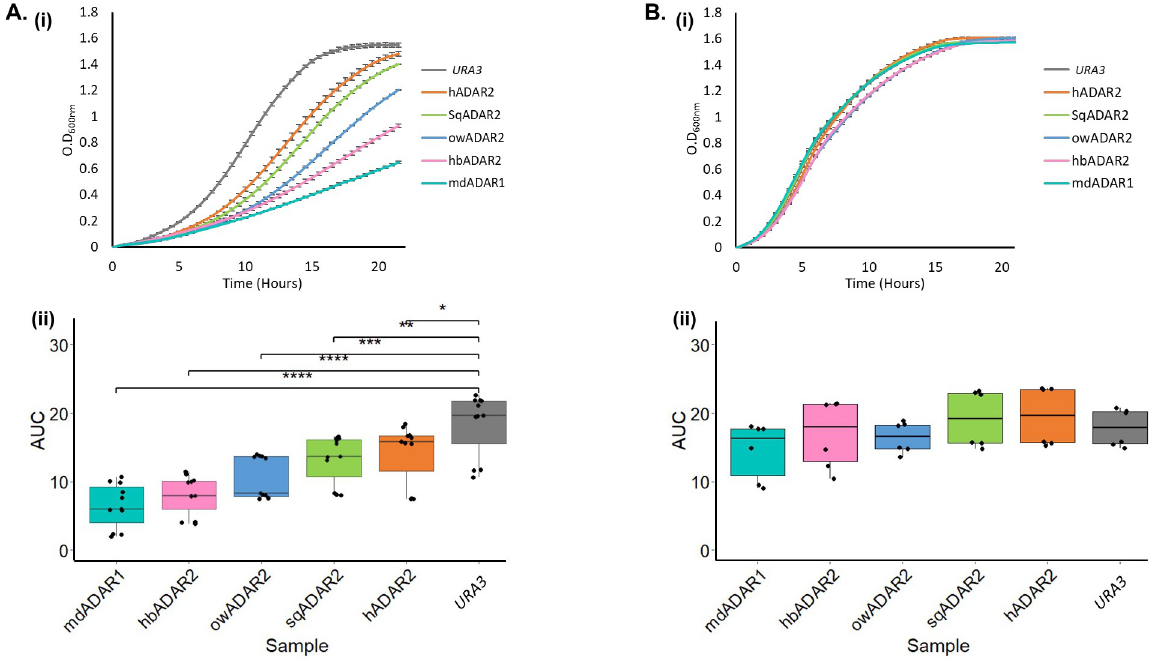
Fig 2. The expression of heterologous ADARs in yeasts impairs growth differently. (A, B) (i) Logarithmic cells carrying hADAR2, sqADAR2, owADAR2, hbADAR2, and mdADAR1, were grown in SC-URA+Raf. Cells were then normalized to an optical density at a wavelength of 600nm (O.D 600nm ) of 0.1 and transferred to SC-URA+Gal (A) and SC-URA+Glu (B) (ADAR expression on and off respectively). Growth was assessed in 96 wells plate using a TECAN microplate reader, by measuring the O.D 600nm in 30 minutes intervals for 22 hours. Cells harboring an empty URA3 marked plasmid were used as a control. Error bars show the standard deviation between three independent experiments. (ii) The growth in A and B was quantitated by calculating the area under the curve (AUC). Whiskers represent the minimum and maximum values measured from three independent experiments. Stars above the boxplots indicate a statistically significant difference between the means of two samples (ns: p > 0.05; � : p < = 0.05; �� : p < = 0.01; ��� : p < = 0.001; ���� : p < = 0.0001).